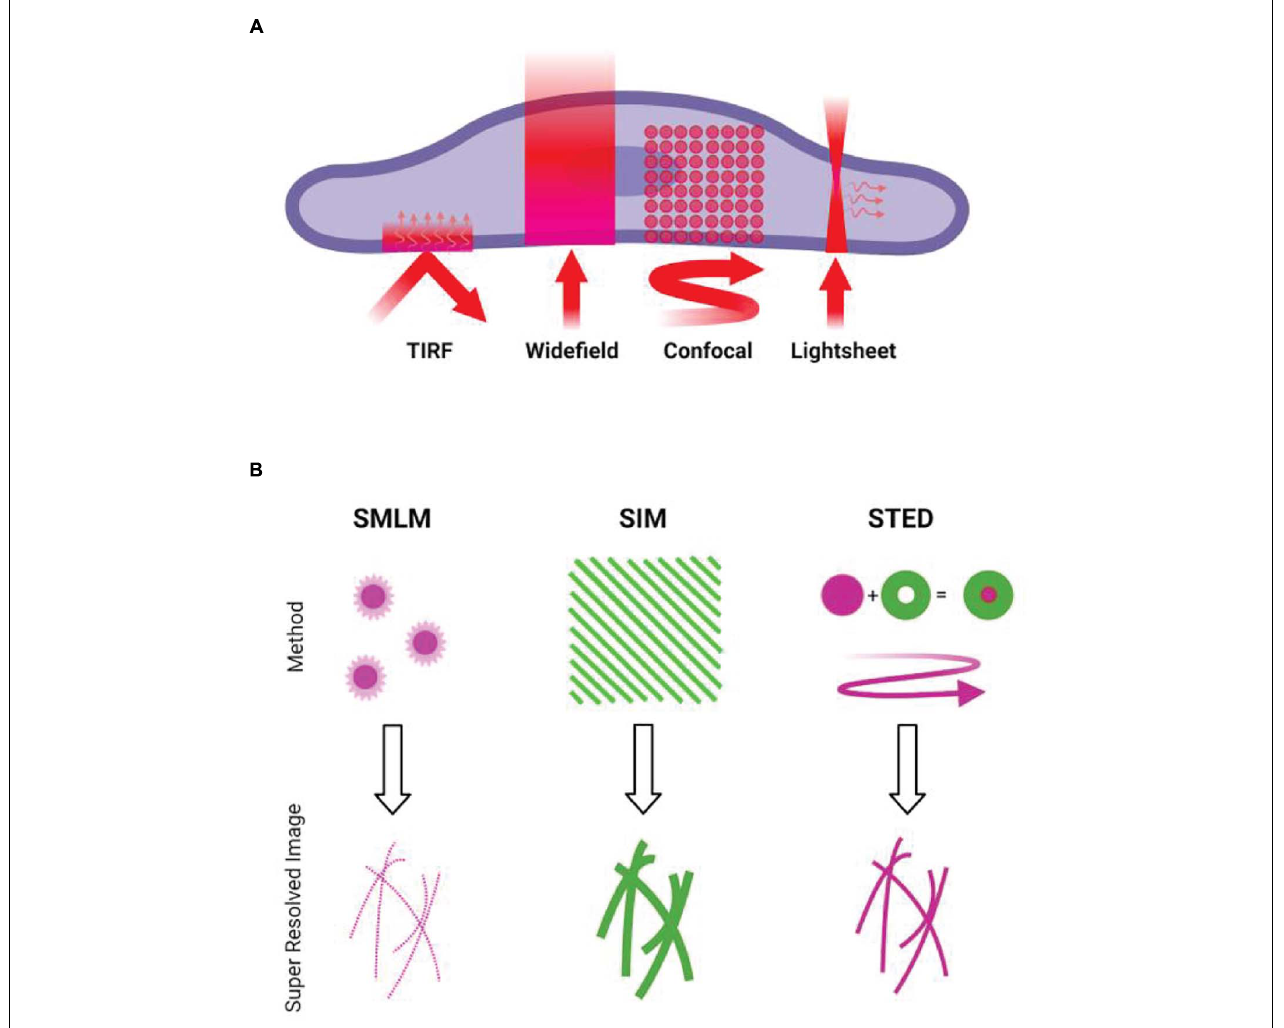
FIGURE 1 | Overview of microscopy techniques commonly used for imaging actin. (A) Diffraction-limited techniques. TIRF, showing the incident light and resulting evanescent wave. Widefield epifluorescence, showing illumination of the full volume of the specimen. Confocal, showing the rastering of the scanning focal point. Lightsheet, showing the sheet illumination and resulting detection at an angle to illumination. (B) Illustrations of the concepts behind common super-resolution techniques. SMLM requires the stochastic activation and localization of single fluorophores, building up a pointillist image of the structure. SIM involves projection of patterned illumination at multiple angles, using the resulting Moiré fringes to reconstruct a higher frequency information. STED uses a depletion laser that surrounds the point of illumination, reducing the size of the point spread function of the illumination